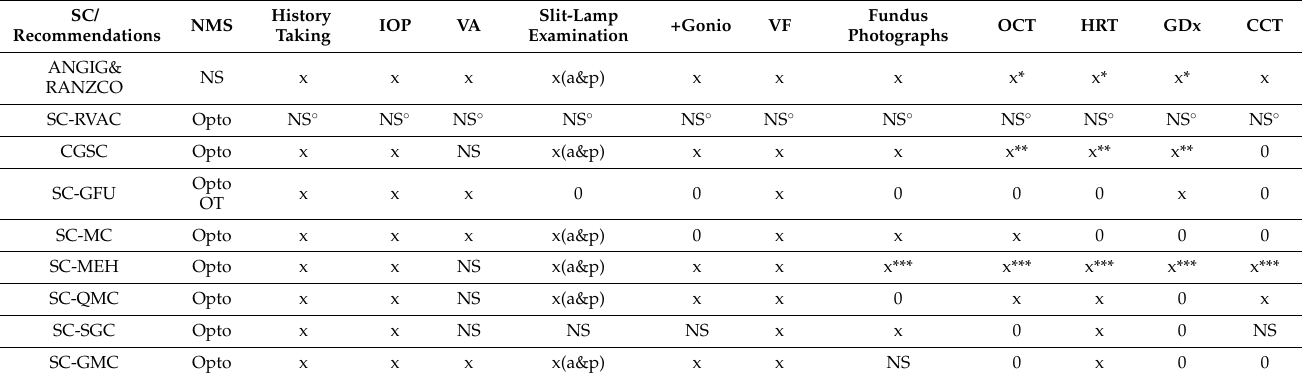
Table 2. The prerequisite skills of the non-medical staff working in the corresponding shared care scheme. SC/ Recommendations